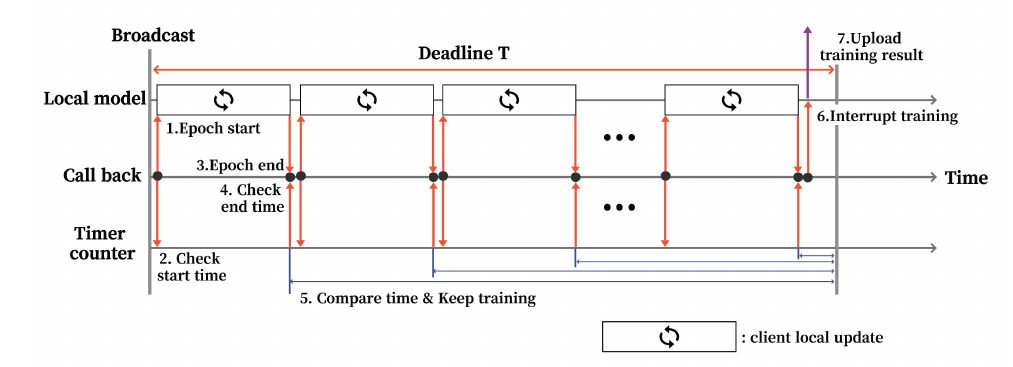
Figure 2. Adaptive local update of the participate